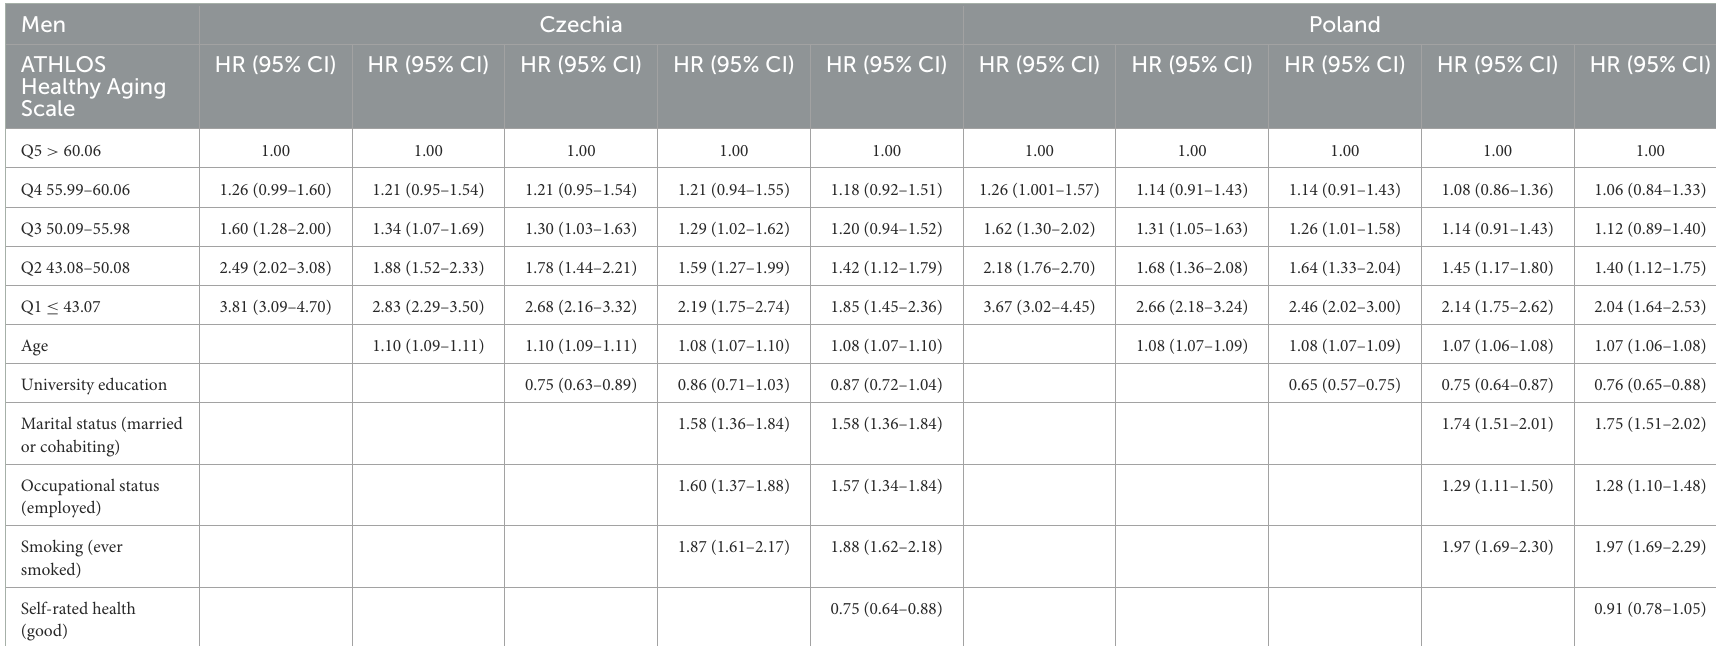
TABLE 4 Association between quintiles of ATHLOS Healthy Aging Scale score and all-cause mortality by country for the men.